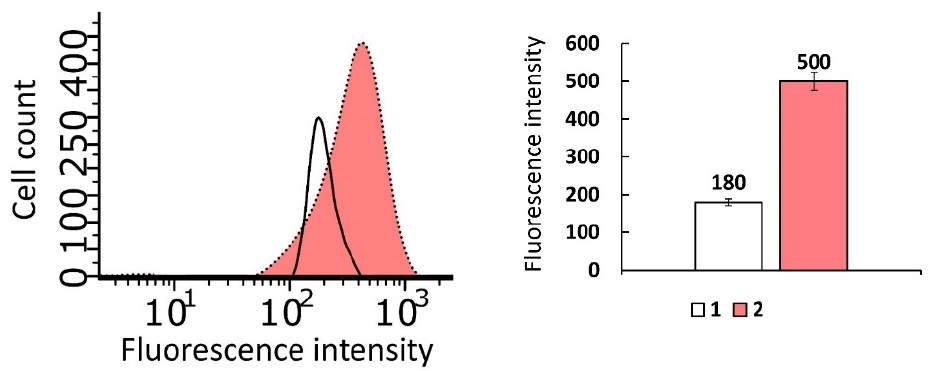
the penetration of the test complexes into M-HeLa cells occurred.